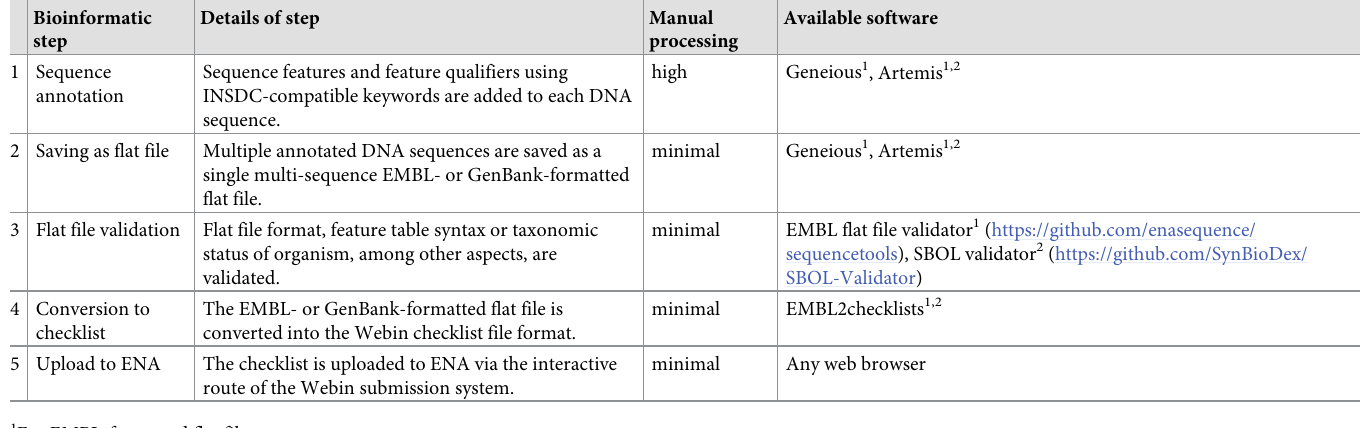
Table 1. Overview of the bioinformatic steps involved in submitting novel DNA sequence data to ENA when using EMBL2checklists, starting from assembled DNA